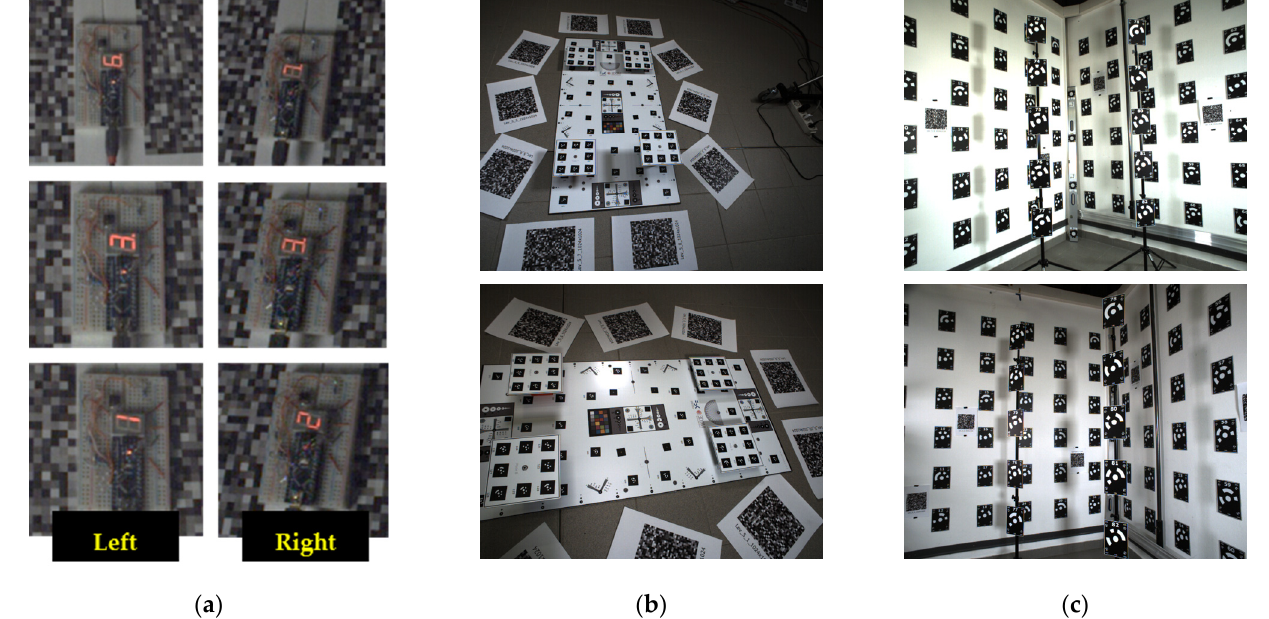
Figure 5. Some images of the millisecond counter: the maximum synchronization error amounts to 1 ms ( a ). Some calibration images showing the small ( b ) and big ( c ) test fields available in the FBK-3DOM lab. Table 2. Calibration results. Exterior parameters of the right camera with respect to the left one.